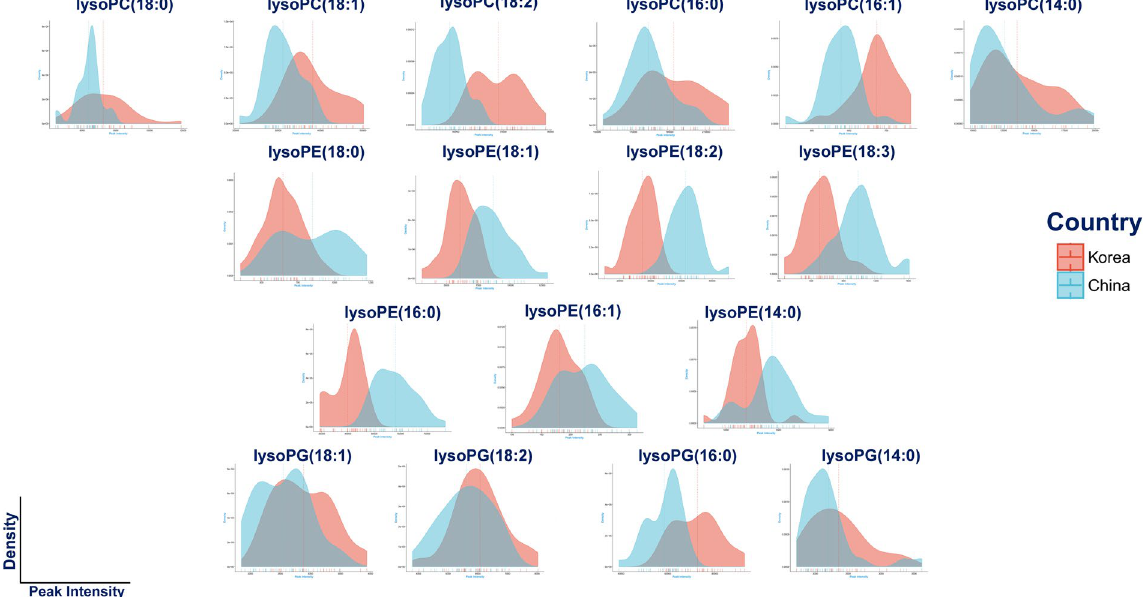
Figure 1. Density plots of 17 lysGPLs of 2014 white rice from Korea and China. lysoPCs are enriched in white rice from Korea while lysoPEs are prominent in white rice from